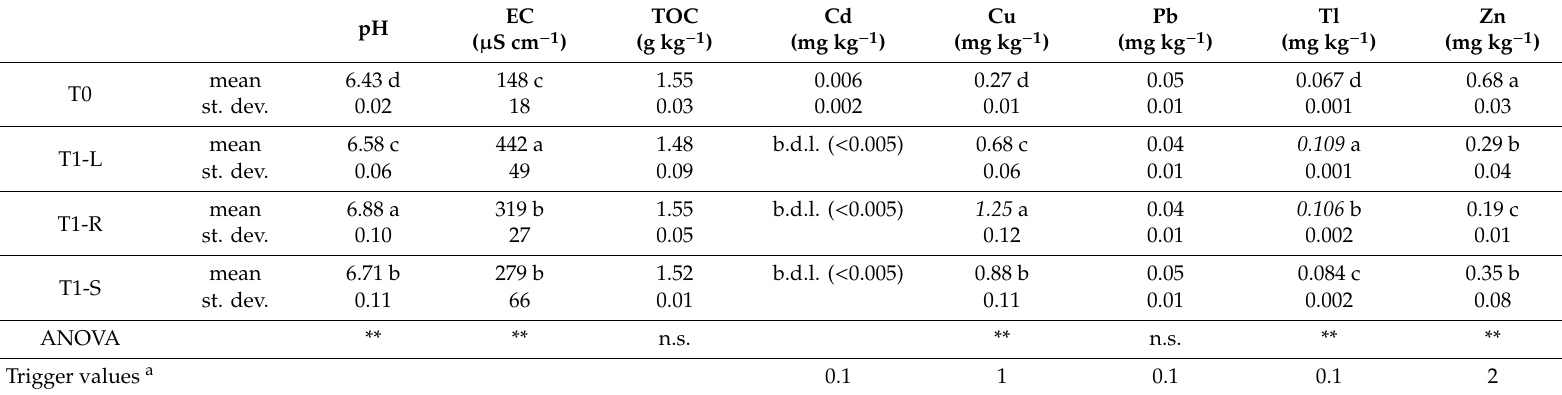
Table 2. pH, electric conductivity (EC), organic C (TOC) and NH 4 NO 3 -extractable Cd, Cu, Pb, Tl and Zn in soil before plant sowing (T0) and at the end of the experiment